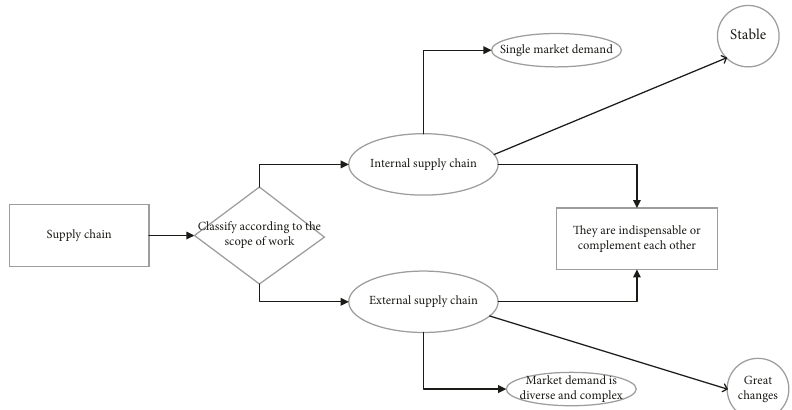
Figure 8: Classification of agricultural product supply chain according to scope of work.